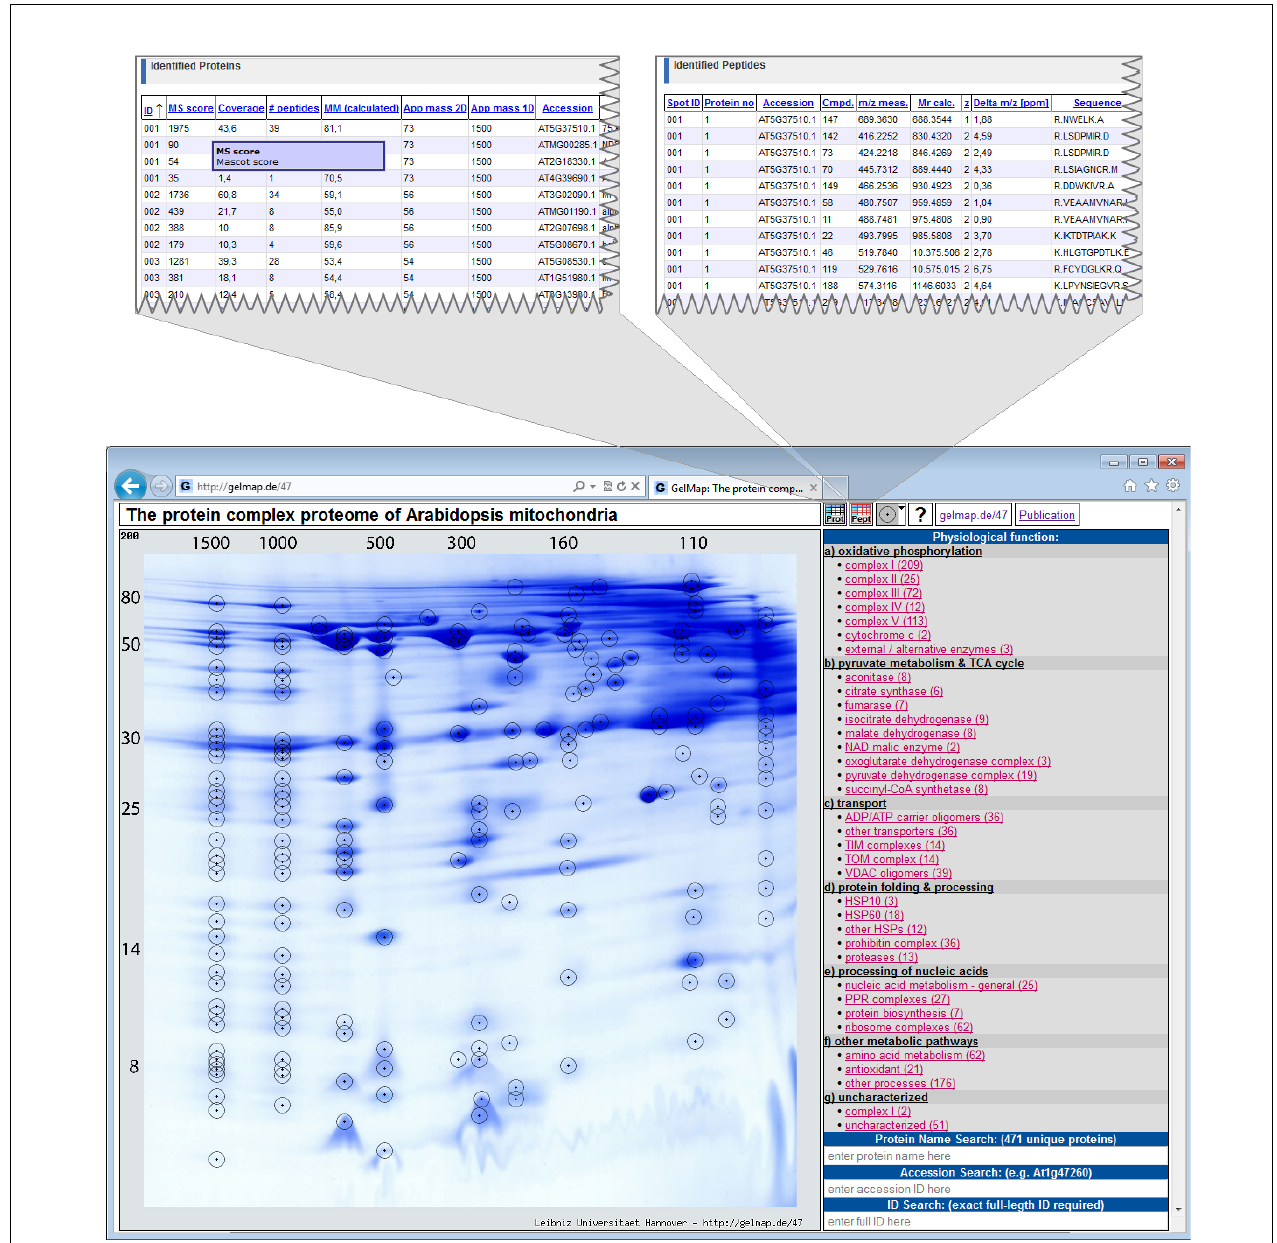
FIGURE 1 | Reference map of the mitochondrial proteome of Arabidopsis thaliana (Klodmann et al., 2011; http://www.gelmap.de/47). Proteins were separated by 2D Blue native/SDS PAGE.The two icons given in the header allow access to the “protein spreadsheet” and the “peptide spreadsheet.”